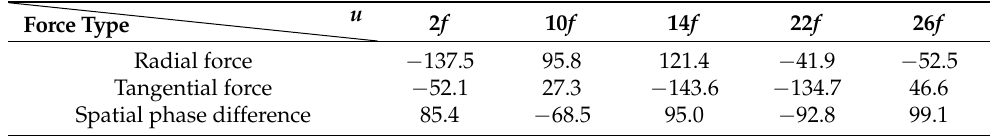
Table 2. Spatial phase of the minimum non-zero spatial order force density under loading operation of a 10-pole 12-slot PMSM (unit: ◦ ).